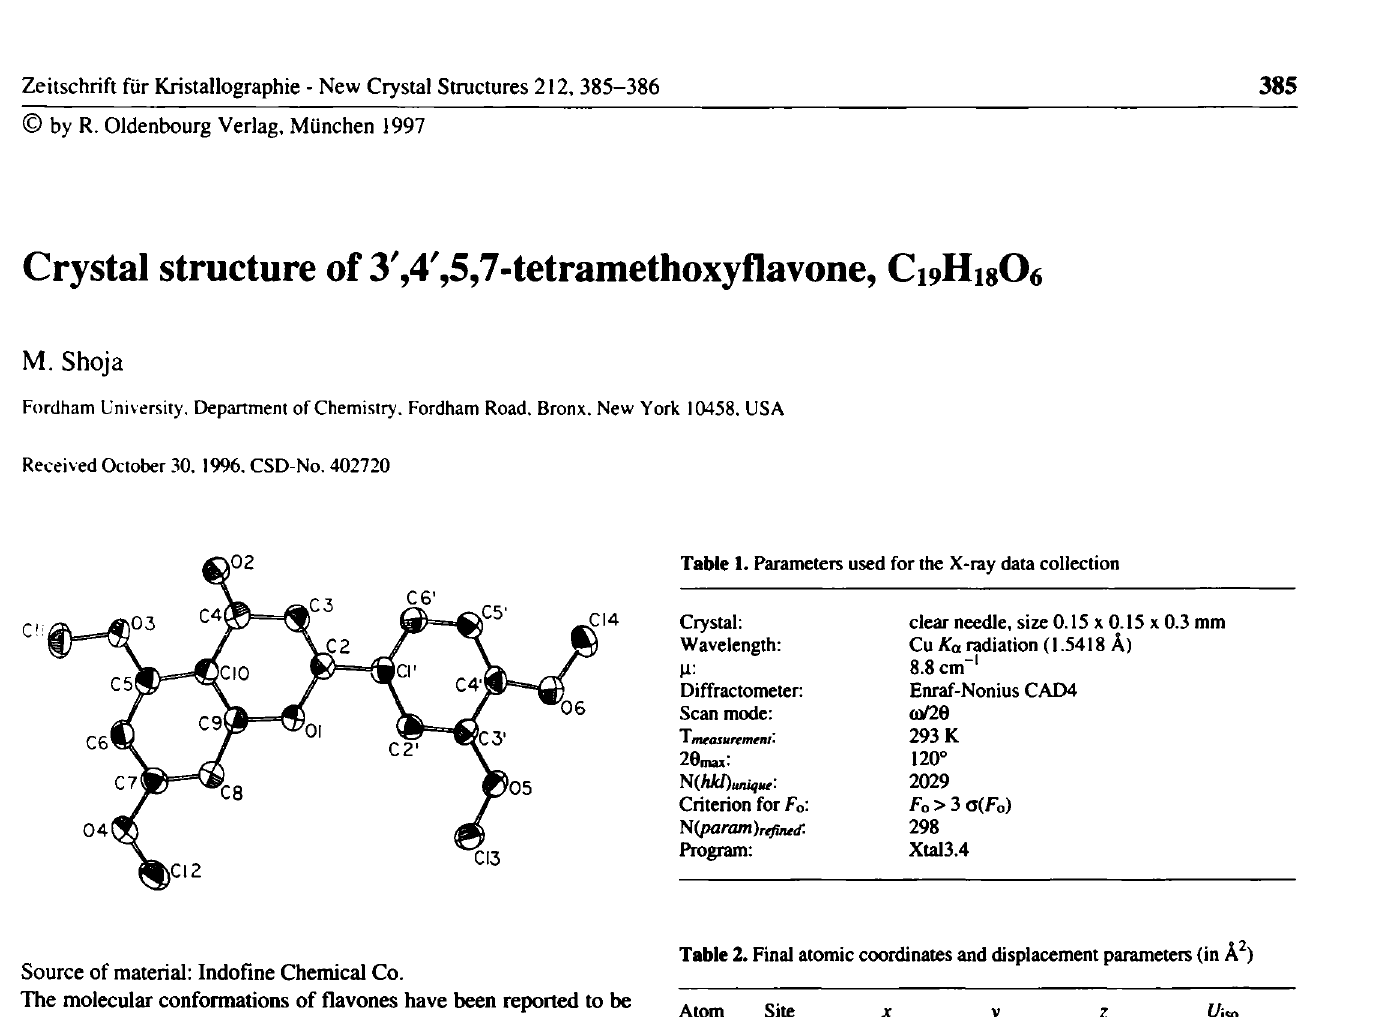
Table 2. Final atomic coordinates and displacement parameters (in Â 2